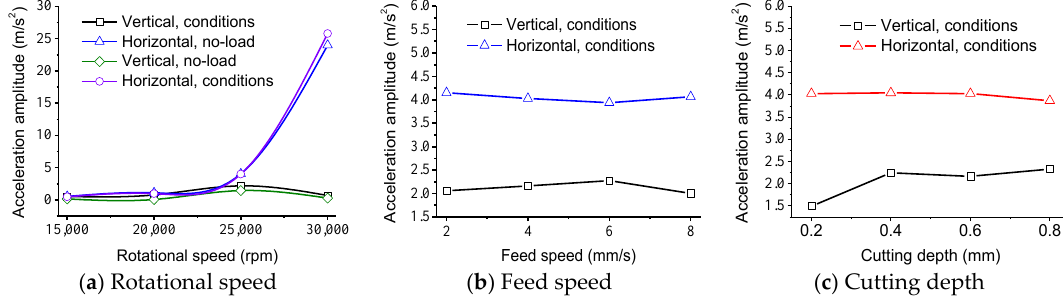
Figure 8. Vibration acceleration amplitude varying with cutting parameters in time domain.